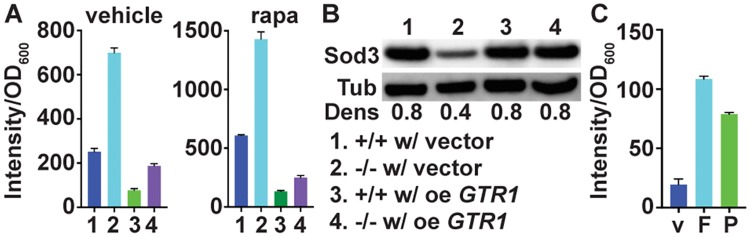
TORC1 activity contributes to ROS management and Sod3 expression.(A) DCFDA-detectable ROS measurement of strains, (1) +/+ containing vector (JKC1594), (2) -/- containing vector (JKC1598), (3) +/+ overexpressing GTR1 (JKC1596), (4) -/- overexpressing GTR1 (JKC1600). Cells cultured overnight in YPD were diluted into SC medium (Loflo) with vehicle or 8 ng/ml rapamycin for 1 hour, and fluorescence intensity was determined after staining cells with 50 μM DCFH-DA. p = 0.0252 for ratio of -/- with vector and -/- overexpressing GTR1 versus ratio of wild type with vector and wild type overexpressing GTR1; all cells exposed to vehicle. p = 0.0014 for ratio of -/- with vector and -/- overexpressing GTR1 versus ratio of wild type with vector and wild type overexpressing GTR1; all cells exposed to rapamycin. p values per Student’s t-test. (B) Western blot of strains as in A, grown in SC medium (Loflo) for 1 hour, probed for Sod3 and loading control tubulin. (C) Wild type (SC5314) cells were exposed to vehicle (v), 0.5 mM foscarnet (F) or 1 mM PAA (P) for 1 hour, and fluorescence intensity was determined as in A. p<0.001 for both 0.5 mM foscarnet versus vehicle and 1 mM PAA versus vehicle. A-C show representatives of at least 3 biological replicates; error bars SD of 3 technical replicates.